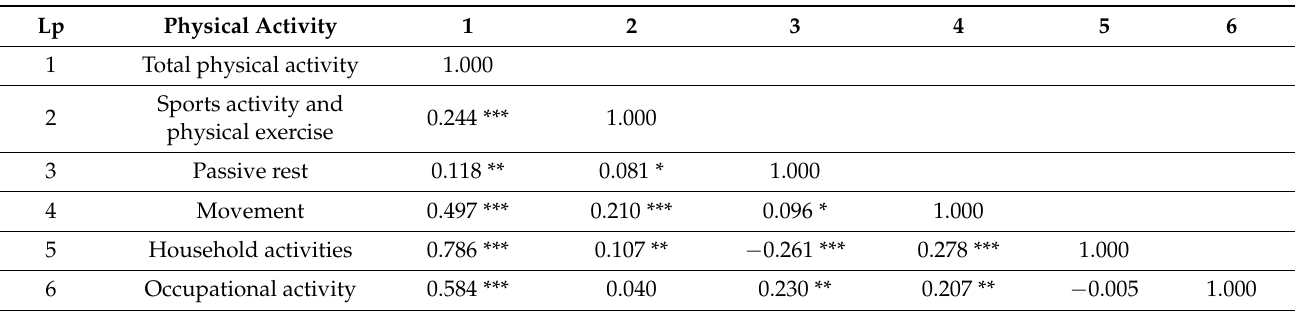
Table 3. Spearman’s Rank Correlations between Total Physical Activity [MET-h/Weeks] and its Components.